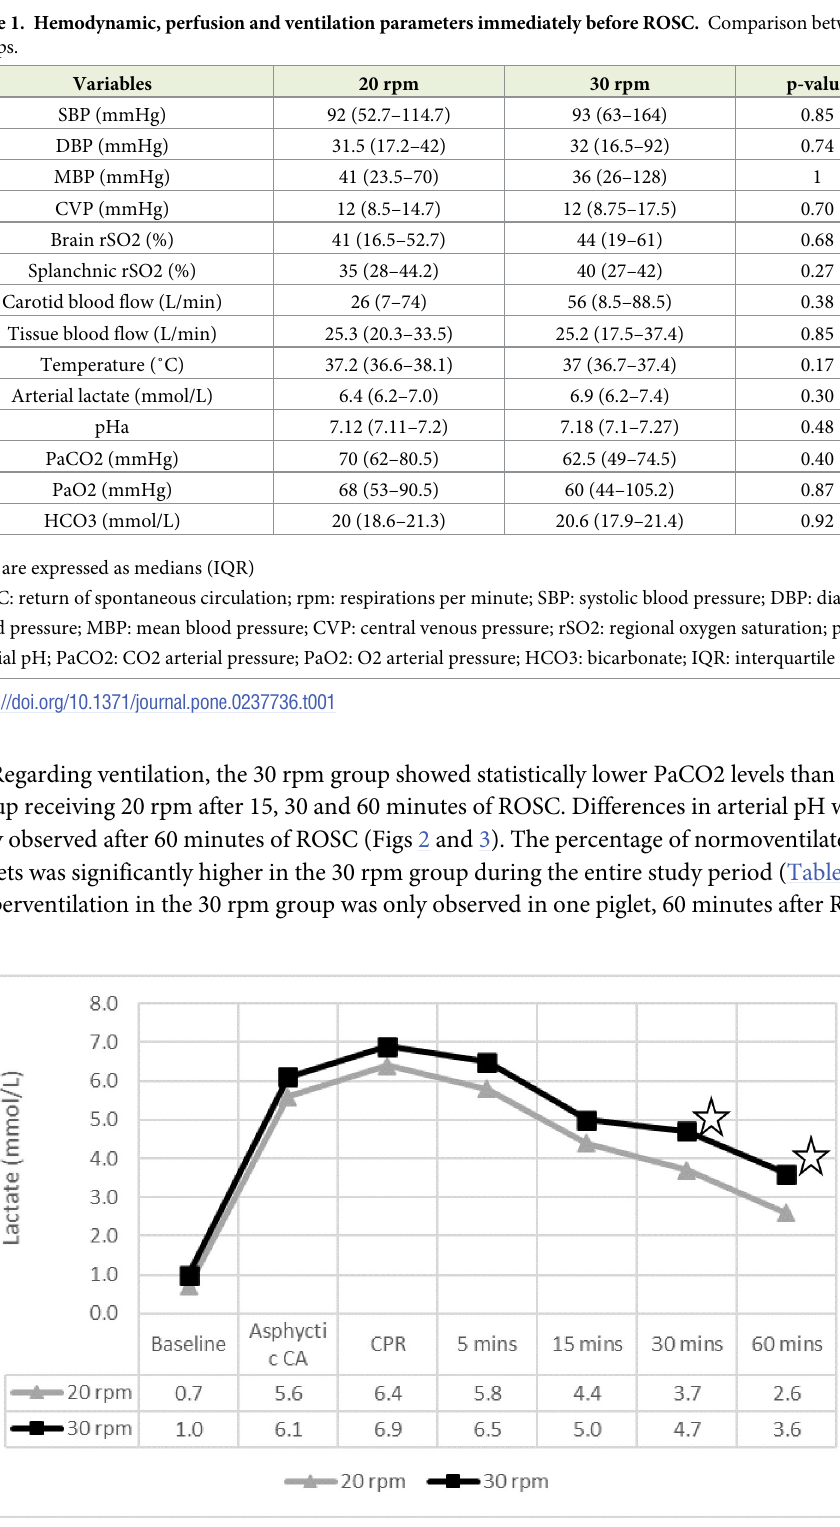
Fig 1. Lactate levels throughout the experiment. ✩ p < 0.05. CA: cardiac arrest; CPR: cardiopulmonary resuscitation; mins: minutes. 5 mins to 60 mins: time after